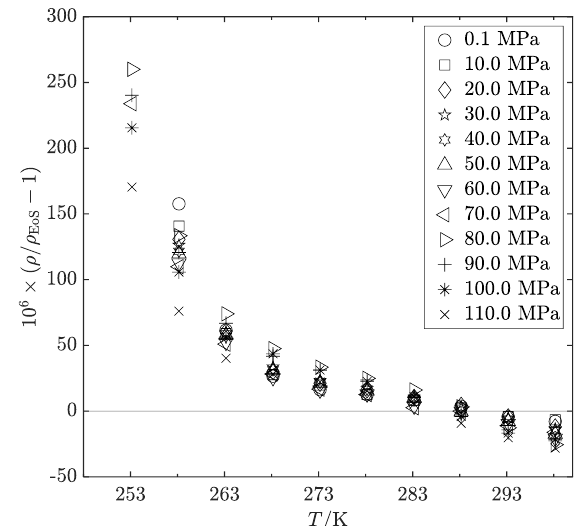
Fig. 6. Relative deviations of H 2 O densities from this work from densities calculated wtih Holten EoS [17] for several isobars.